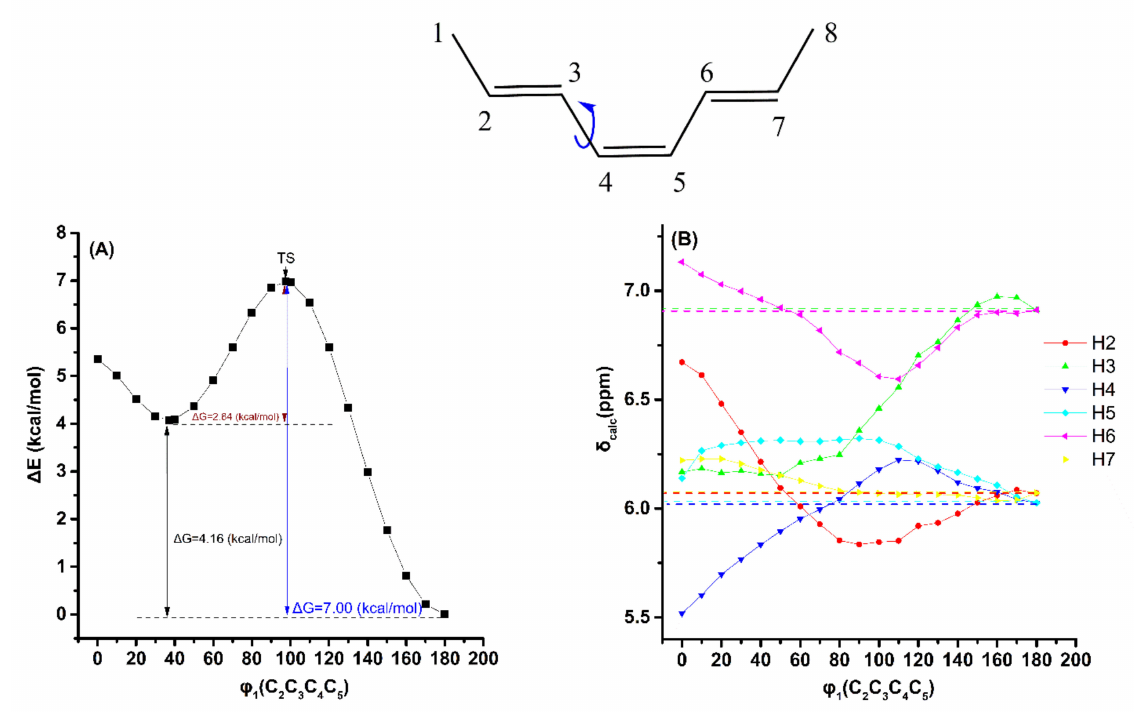
Figure 4. Effect of variation in the torsion angle ϕ 1 (C 2 C 3 C 4 C 5 ) of ( E , Z,E )-2,4,6-octatriene, with energy minimization at the B3LYP/6–31+G(d) level, on the electronic energy ∆ E (kcal/mol) (characteristic ∆ G values are also shown) ( A ) and on the olefinic δ calc ( 1 H) data (at the GIAO/B3LYP/6–311+G(2d,p) level with CPCM in CHCl 3 ) ( B ). The experimental chemical shift values are denoted with the horizontal dotted